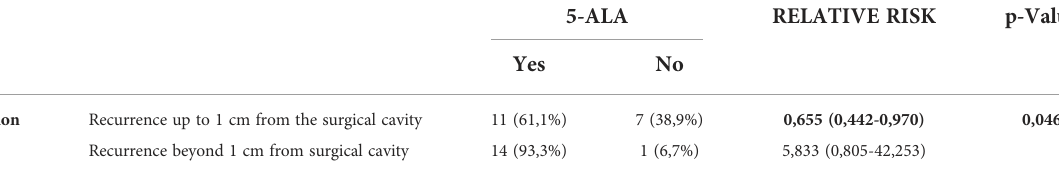
TABLE 2 Univariate analysis.